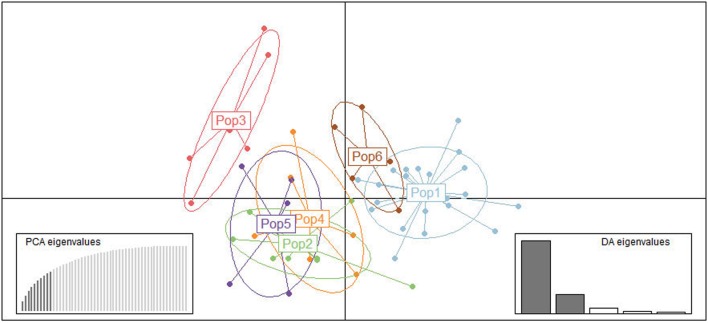
Genetic structure of Theileria annulata populations in China based on discriminant analysis of principal components (DAPC). Each population is pointed out by different color symbols. Pop1: Xinjiang; Pop2: Liaoning; Pop3: Gansu; Pop4: Inner Mongolia; Pop5: Tianjin; Pop6: Hainan.